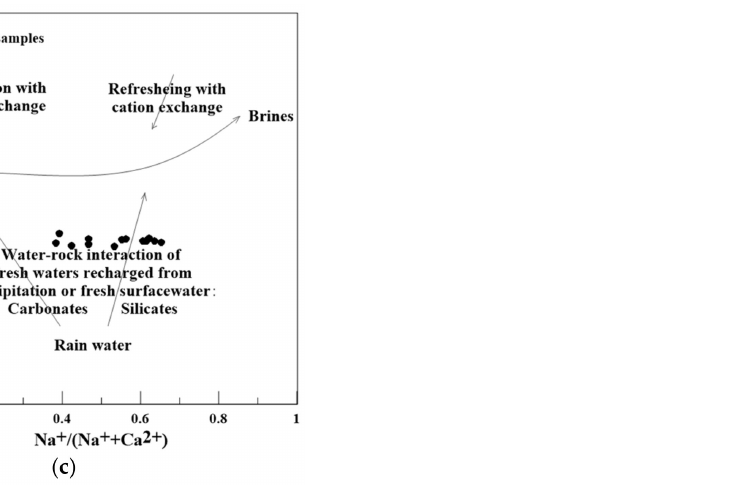
Figure 6. Mineral water formation process: ( a ) Schoeller diagram, ( b ) Gibbs diagram, ( c ) modified Gibbs diagram.